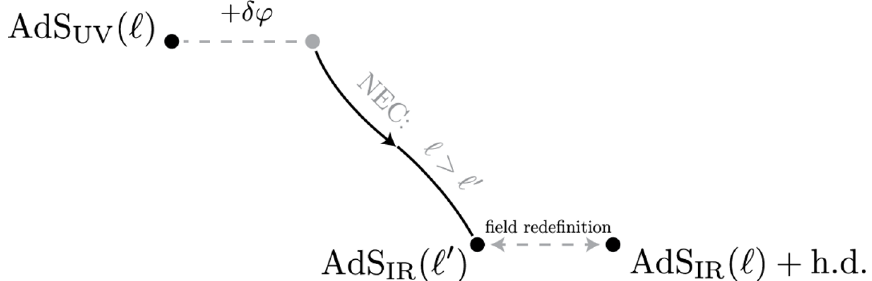
Figure 3 . If we perturb an AdS space with AdS length ‘ by a relevant deformation δϕ , this triggers an RG flow until we reach an IR fixed point describing an AdS space with length ‘ 0 . When δϕ satisfies the NEC, ‘ > ‘ 0 . By a field redefinition, the action of the IR AdS space can be related to an AdS space with length ‘ and higher-derivative